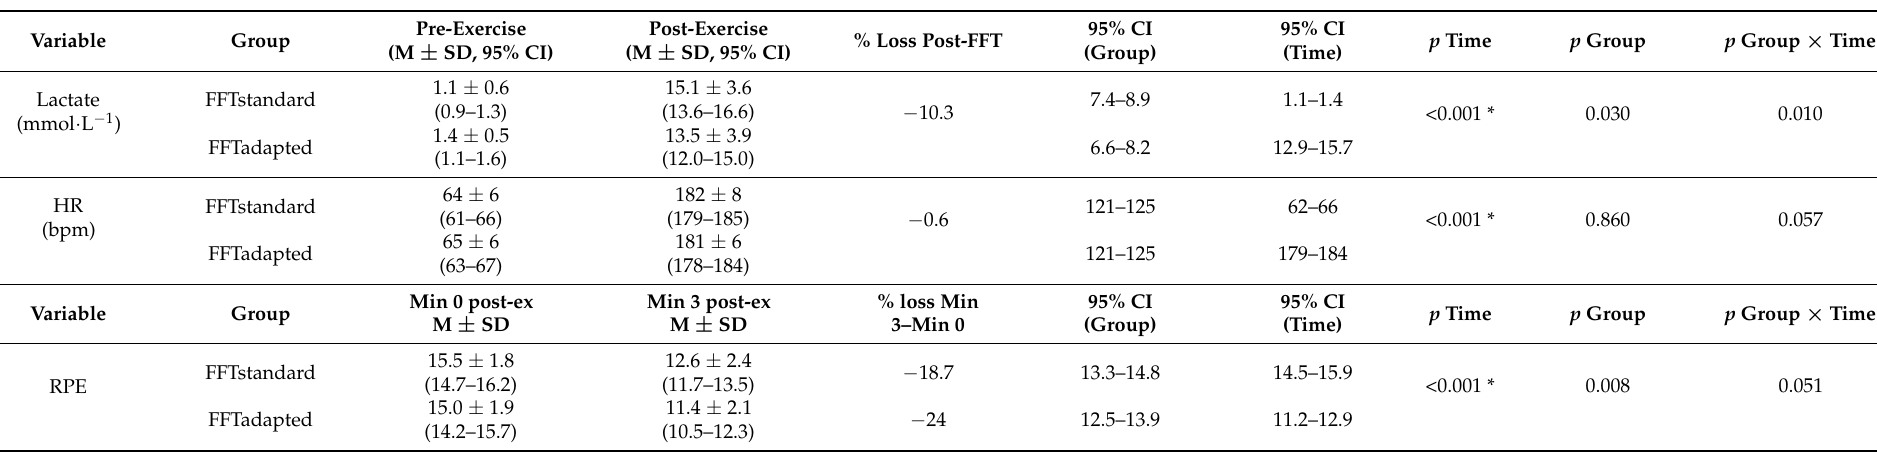
Table 1. Cardiometabolic variables and perceived exertion recorded in the standard and adapted FFT